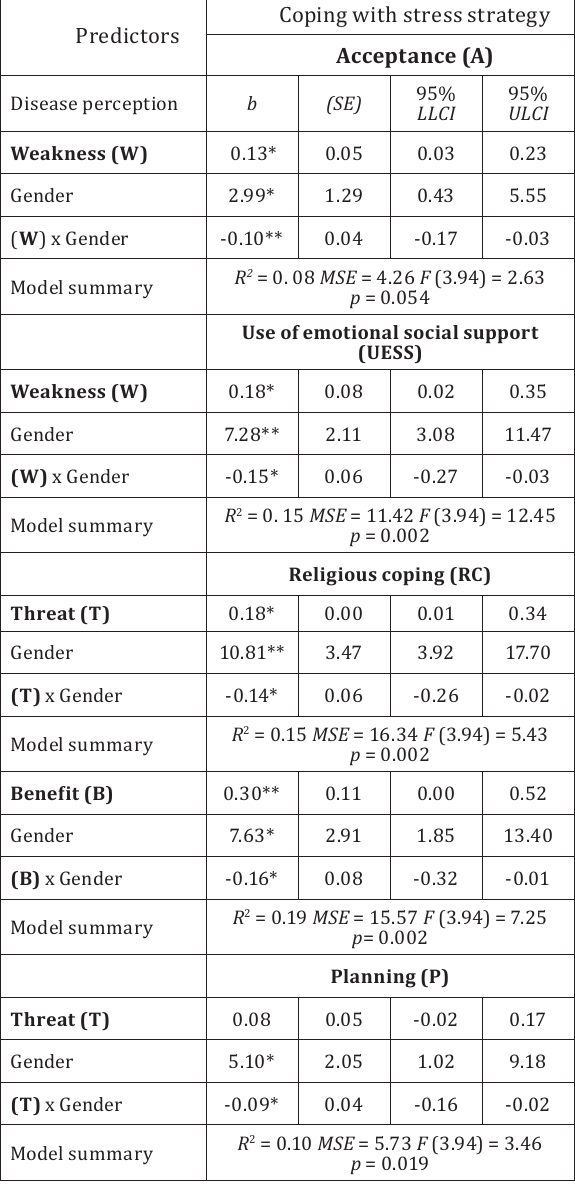
Table 1. Gender as a moderator of the relationship